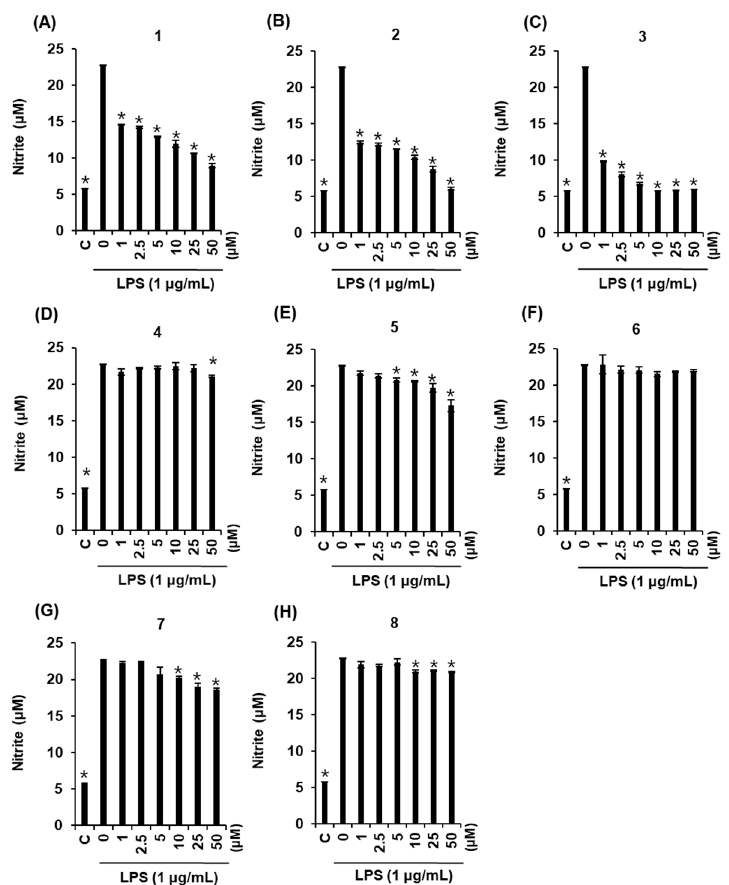
Figure 3. Anti-inflammatory effects of the isolated compounds: inhibition of LPS-induced NO production in RAW264.7 mouse macrophages. Inhibitory effects of isolated compounds 1 ( A ), 2 ( B ), 3 ( C ), 4 ( D ), 5 ( E ), 6 ( F ), 7 ( G ), and 8 ( H ) on LPS-induced NO production in RAW264.7 mouse macrophages. The cells were pretreated with the indicated concentrations of samples for 2 h and then exposed to 1 µ g/mL LPS for 24 h. * p < 0.05 compared to the LPS-treated value.